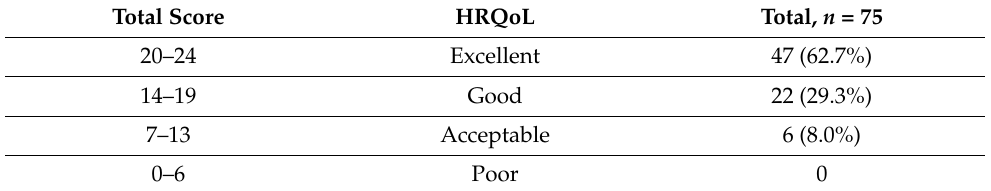
Table 1. Total scores of health-related quality of life from the original cohort